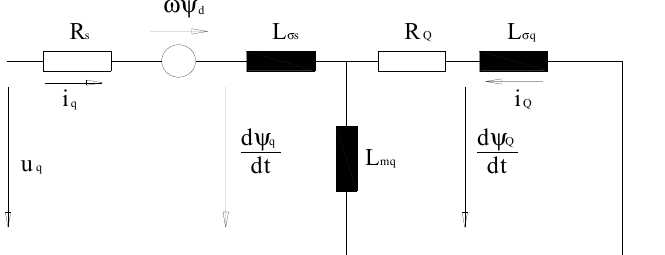
Figure 5. Synchronous machine equivalent diagram for d-axis adapted with permission from ref. [1]. Copyright 2021 IEEE.